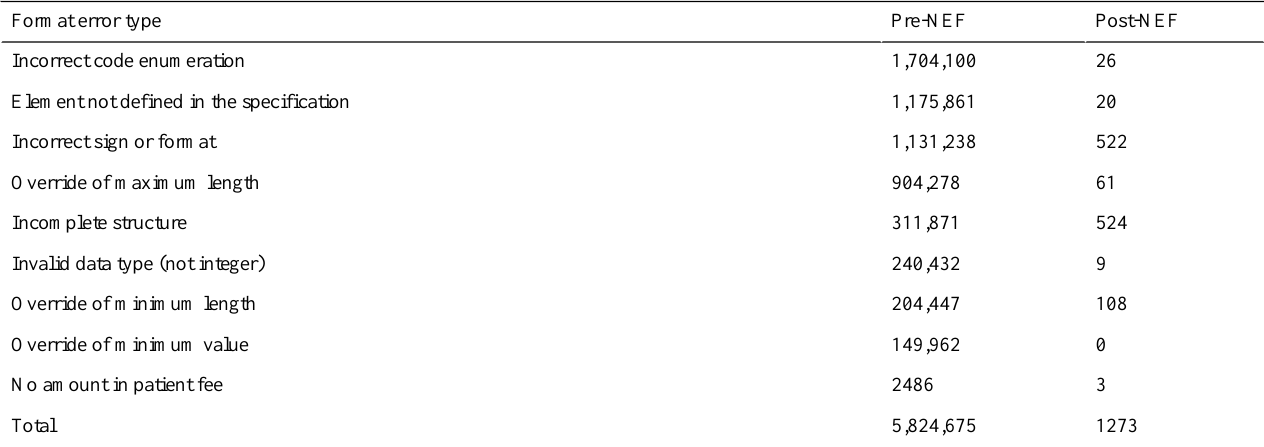
Table 10. Number of format errors (XML-Schema validation errors) in pre-NEF and post- NEF prescriptions grouped by type of